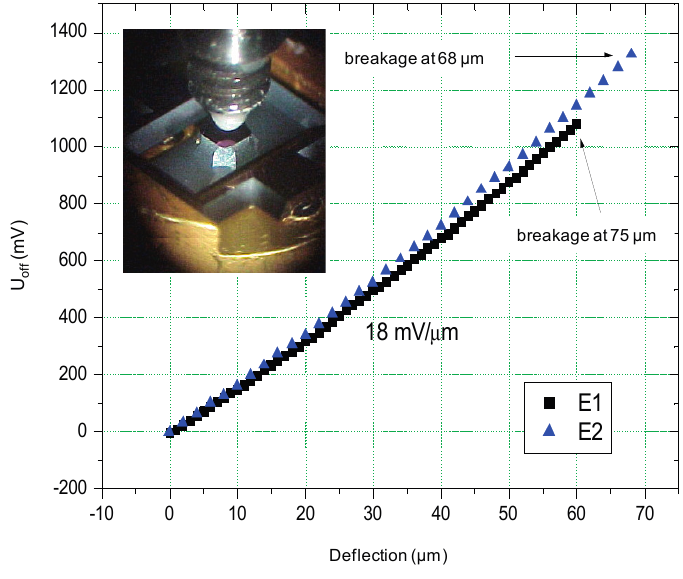
Figure 10. Output signals measured with fabricated SOI sensor chips